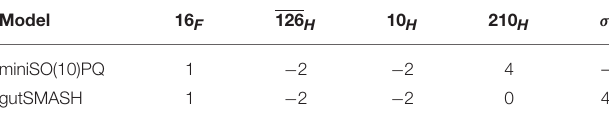
U (1) PQ (Di Luzio et al., 2018) and ×